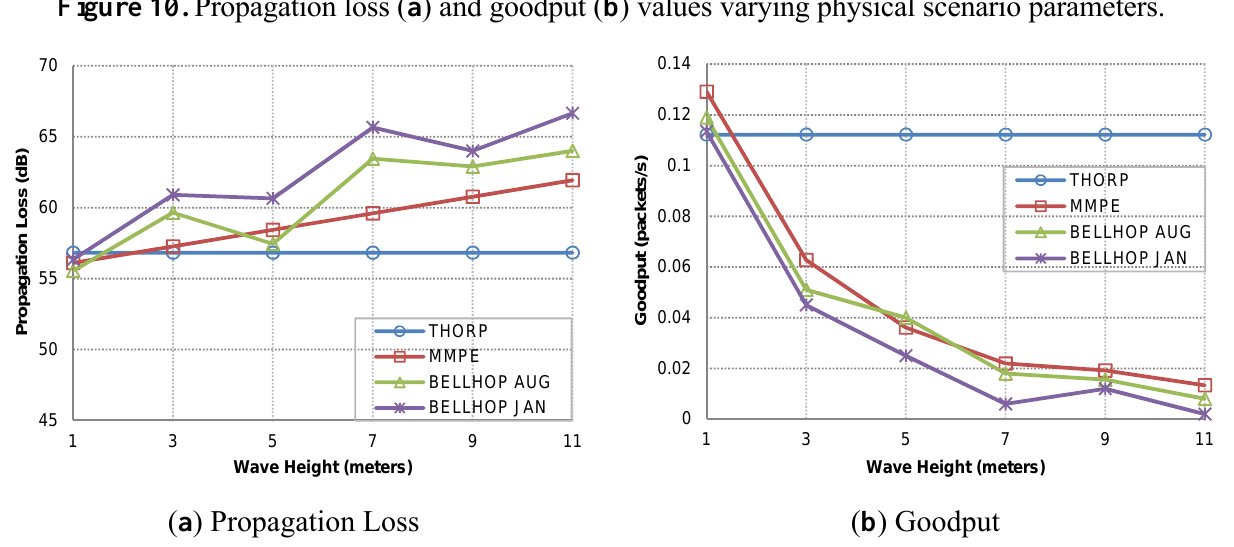
Figure 10. Propagation loss ( a ) and goodput ( b ) values varying physical scenario